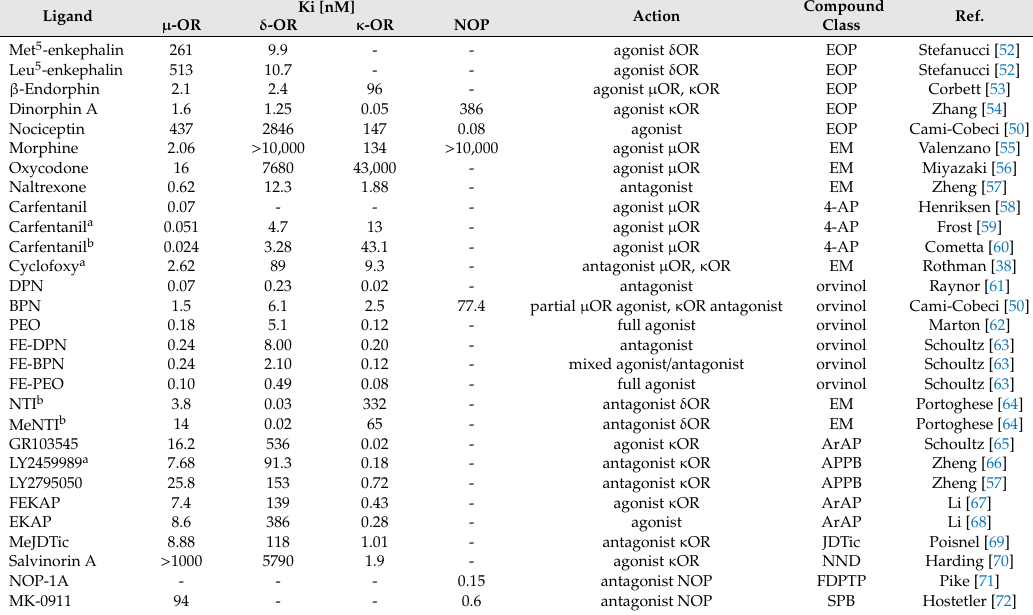
Table 1. Binding profile of selected ligands at the human opioid receptors [51] . Ki [nM] Compound Ligand µ -OR Action Class Ref.